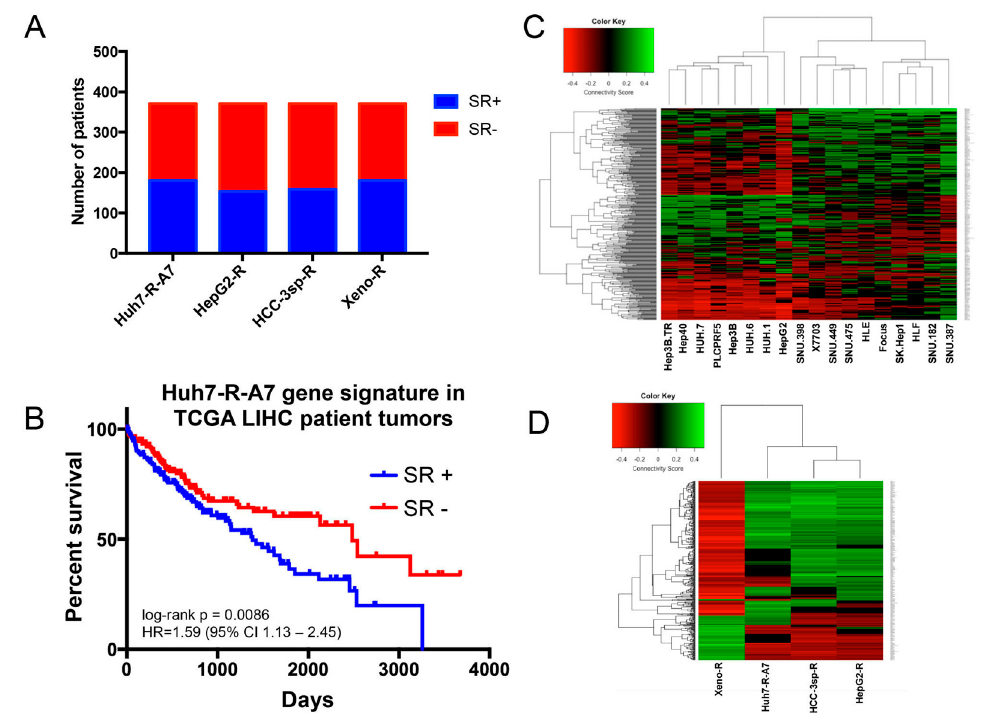
Figure 2. Sorafenib resistance gene signatures—prognostic significance and drug repurposing candidates. ( A ) Percentage of primary tumor samples in The Cancer Genome Atlas (TCGA) liver hepatocellular carcinoma (LIHC) dataset containing the four sorafenib resistance gene signatures (SR+). ( B ) Kaplan–Meier plot of overall survival of TCGA LIHC patients with primary tumors harboring the Huh7-R-A7 SR gene signature (n = 181 SR+) and those with primary tumors containing the inverse SR gene signature (n = 190 SR-). Heatmap visualization of hierarchical clustering analysis of connectivity scores for LINCS drugs derived from gene expression profiles of ( C ) HCC cell lines (n = 18) from the CellMiner database and ( D ) HCC sorafenib resistance (SR) experimental models.